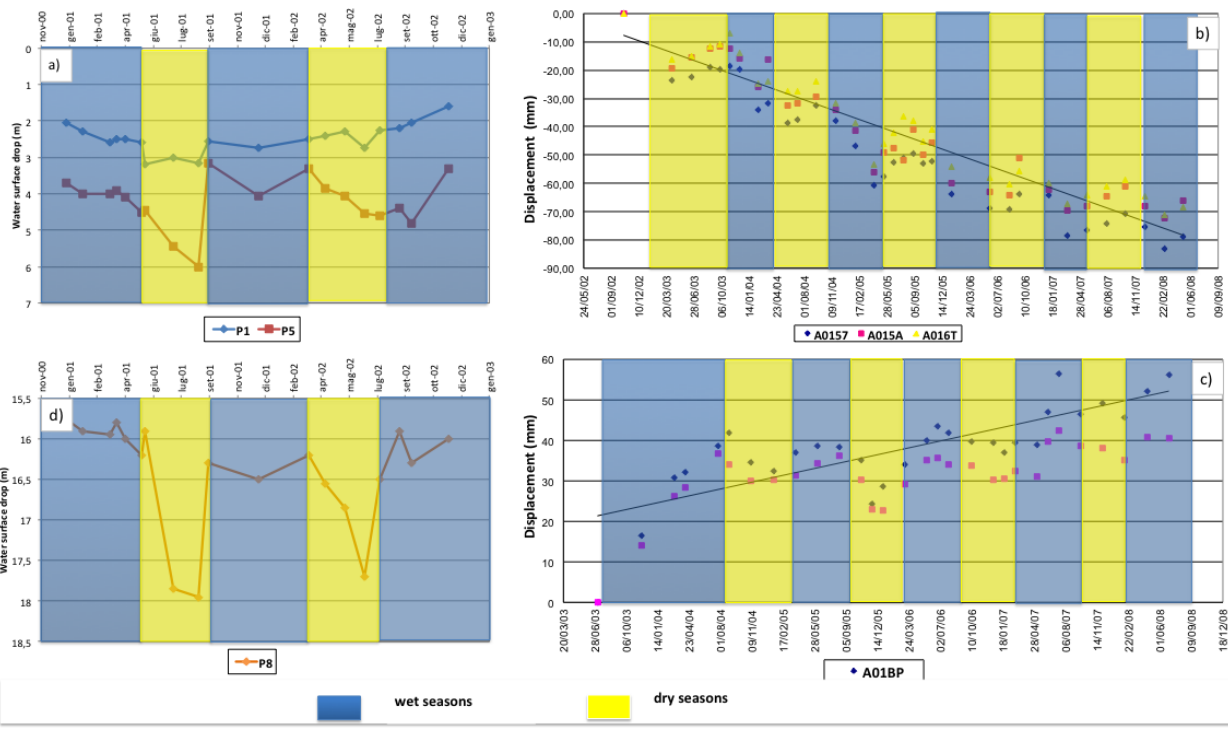
Figure 8. Comparison of PS ® time series of displacement and piezometric level